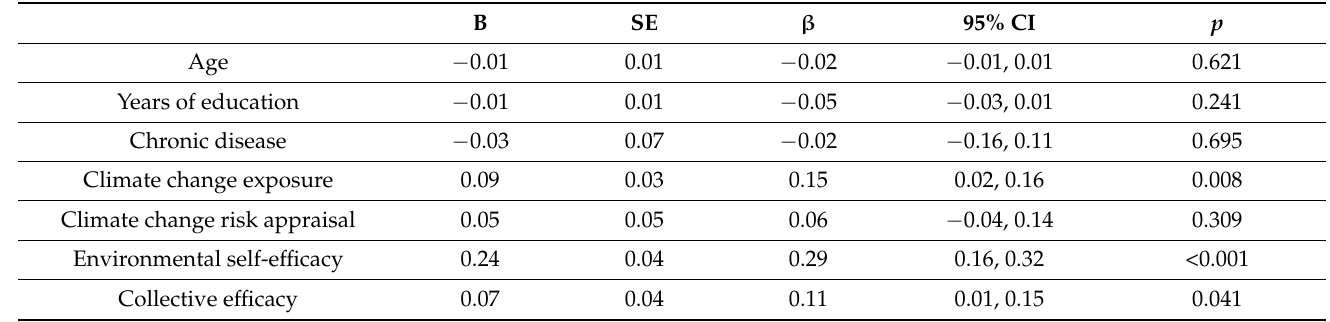
Table 4. Multiple linear regression for pro-environmental behaviors (N = 402).